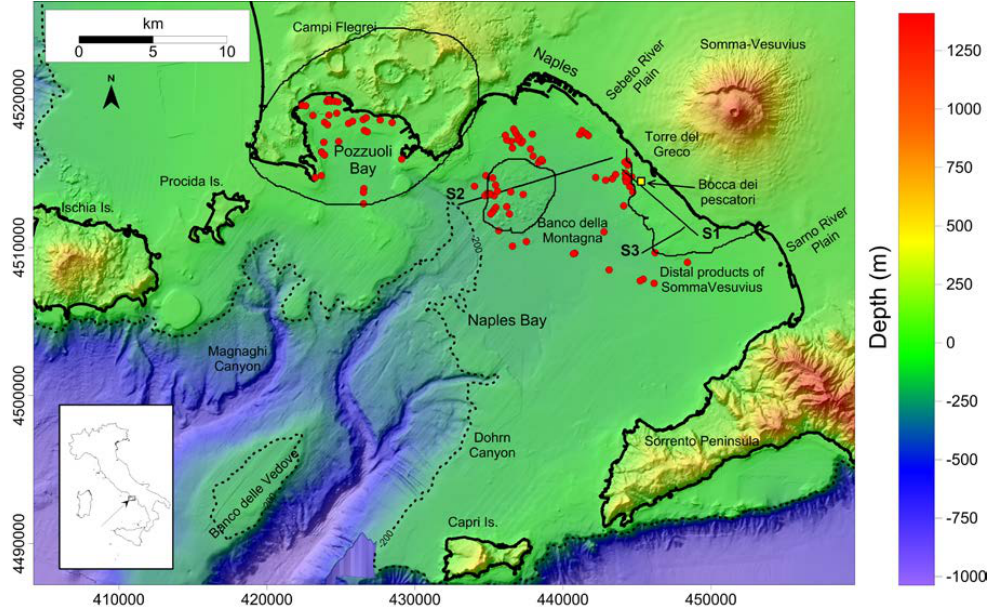
Figure 1. Location map of the shelf area of Naples Bay with in black solid line the coastal margin. Red dots are fluid vents after [8]. The dashed line represents the − 190 m isobaths, roughly coinciding with the shelf break boundary. S1, S2, and S3 indicate the navigation of seismic profiles shown in the manuscript.